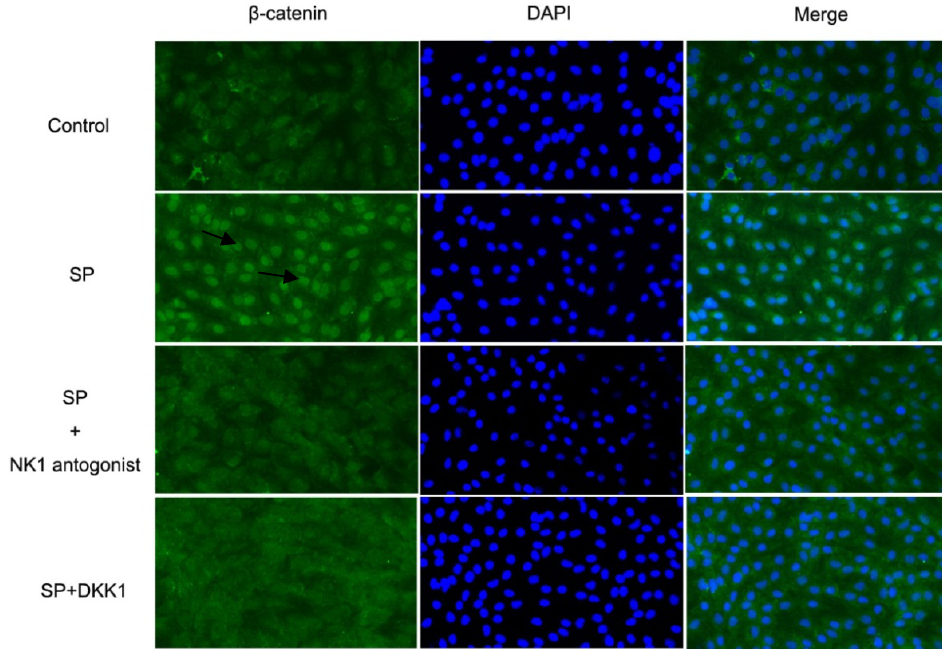
Figure 6. Effects of SP, SP + NK1 antagonist, and SP +DKK1 on β -catenin activation in MC3T3-E1 cells. Immunofluorescence staining with antibodies of β -catenin. Cells were incubated in the presence of SP, SP + NK1 antagonist, SP + DKK1, and the same amount of PBS for 4 days, then the β -catenin was detected by the immunostaining method as shown in green fluorescence (arrowheads). The nuclei were stained with 4'-6-diamidino-2-phenylindole (DAPI) as shown in